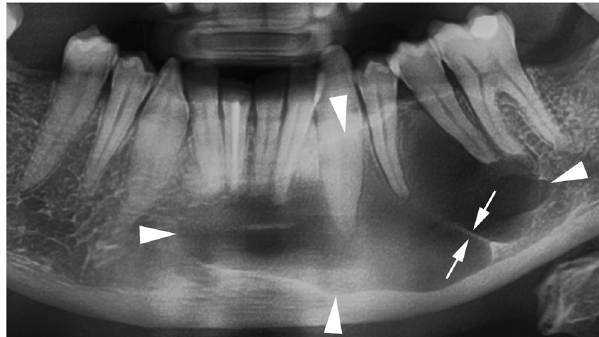
Fig. 2 Cropped panoramic radiograph shows a large OKC with well- defined and lobulated margins ( arrowheads ) occupying the body of the mandible. Note an incomplete internal septum within the lesion ( opposing arrows